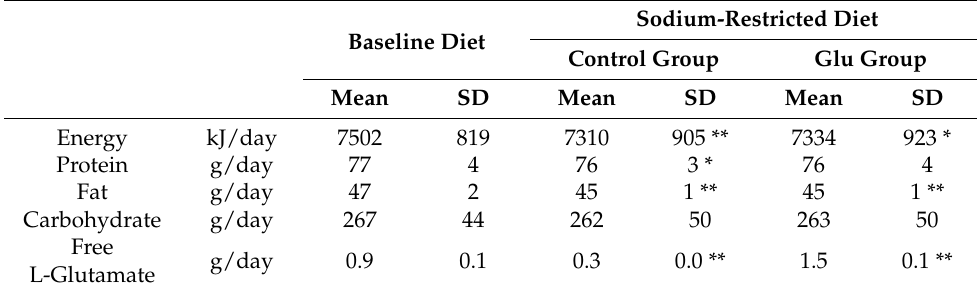
Table 2. Energy and nutrient intakes during baseline and the sodium-restricted diets.